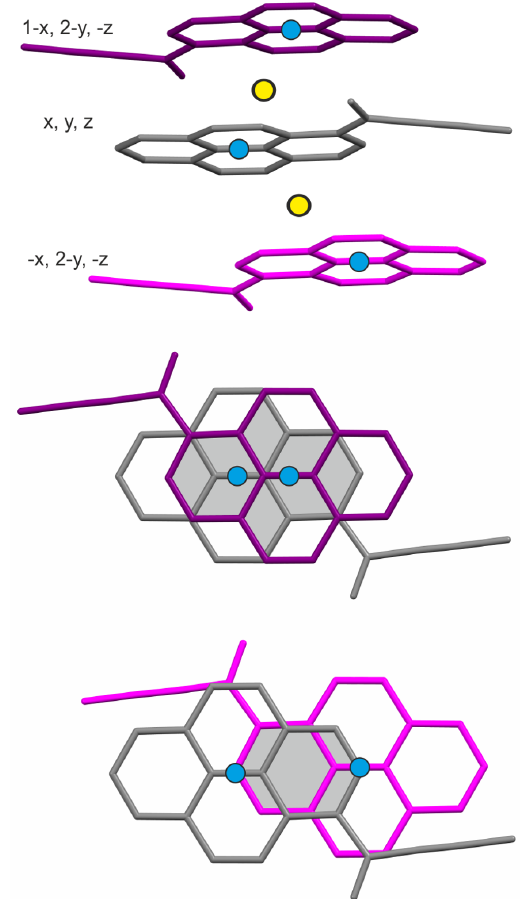
Figure 2. Top: a fragment of the infinite π -stack in the structure of compound 1a viewed along [001]; crystallographic centers of symmetry indicated as yellow dots; the independent molecule of 1a in the asymmetric unit represented in grey, the two closest neighbors of 1a in a stack represented in purple and magenta, with symmetry codes of the molecules on the left; the centers of each pyrene moiety represented as blue dots. Middle and bottom-views perpendicular to the average pyrene planes, roughly along [100], illustrating the vertical overlap of pyrene moieties and the lateral shifts of their centers; the longer interplanar distance (purple) is associated with larger vertical overlap of pyrene